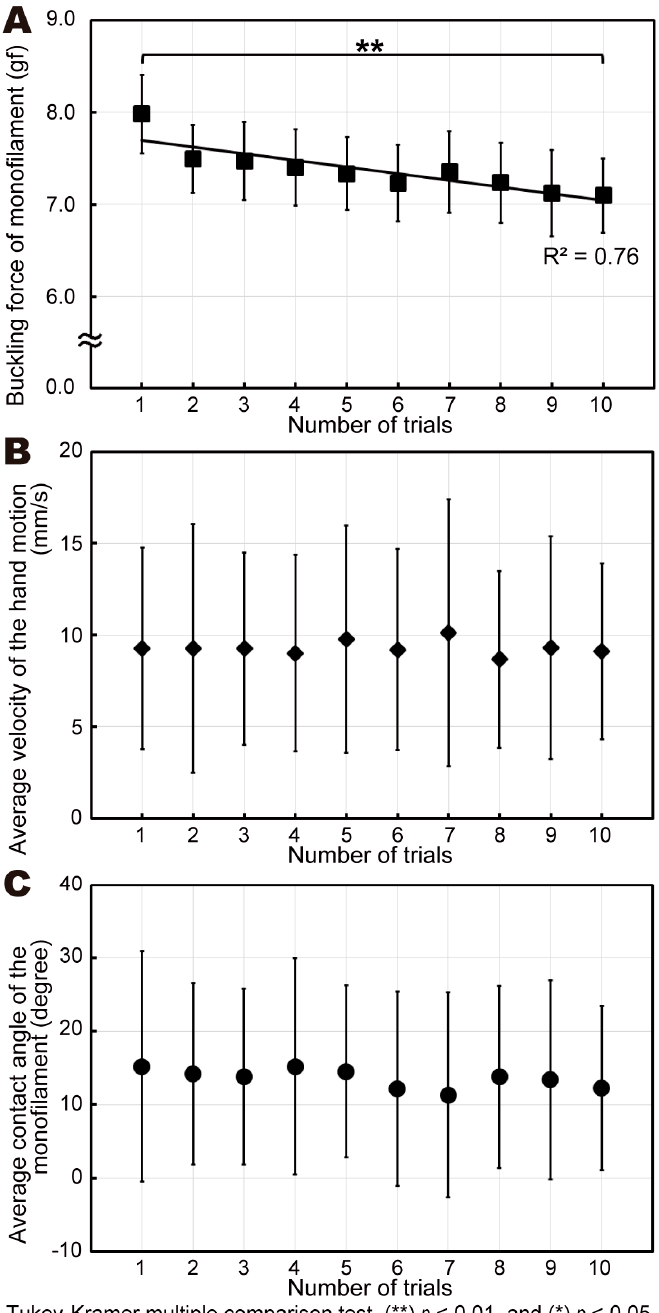
Figure 3. Experimental results of manual (human) operation: ( A ) monofilament buckling forces for each trial; ( B ) average velocity of human hand motion; ( C ) average contact angle of the